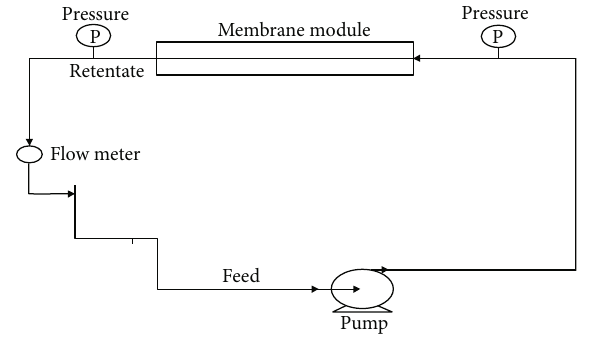
Figure 1: Schematic diagram of cross- fl ow WPE/PAMK-TFN membranes fi ltration unit.